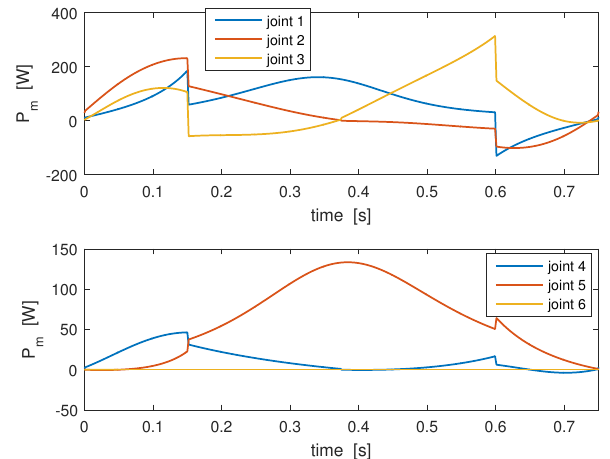
Figure 4. Motor electric power for nominal tool orientation: ϕ = 0 rad , θ = 0 rad , ψ = 3 π /2 rad . The overall consumption associated with the task, evaluated according to Equation (6), is equal to 220.4 J